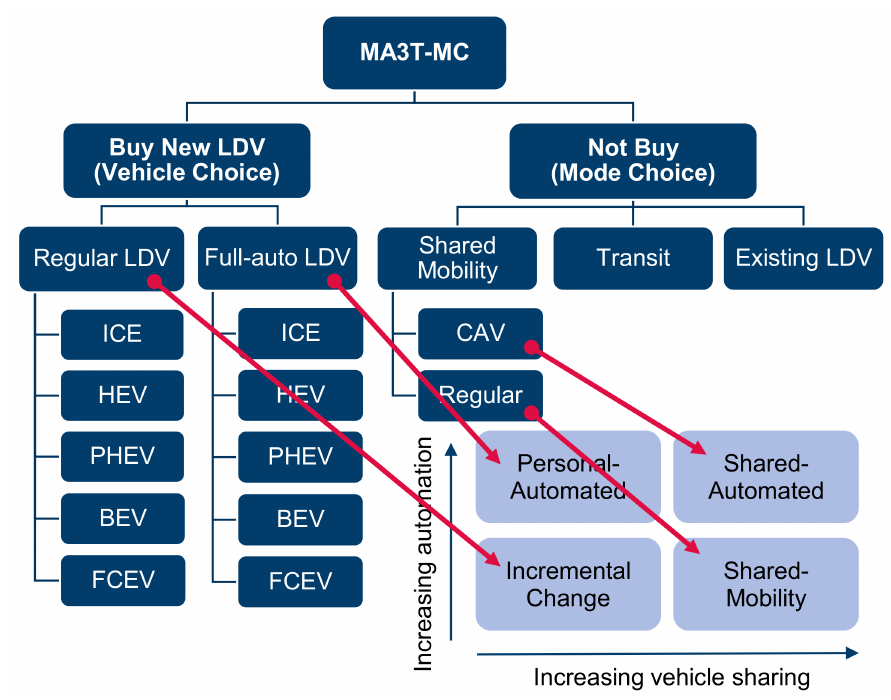
Figure 9. New modes to include vehicle automation and shared mobility in MA3T-MC